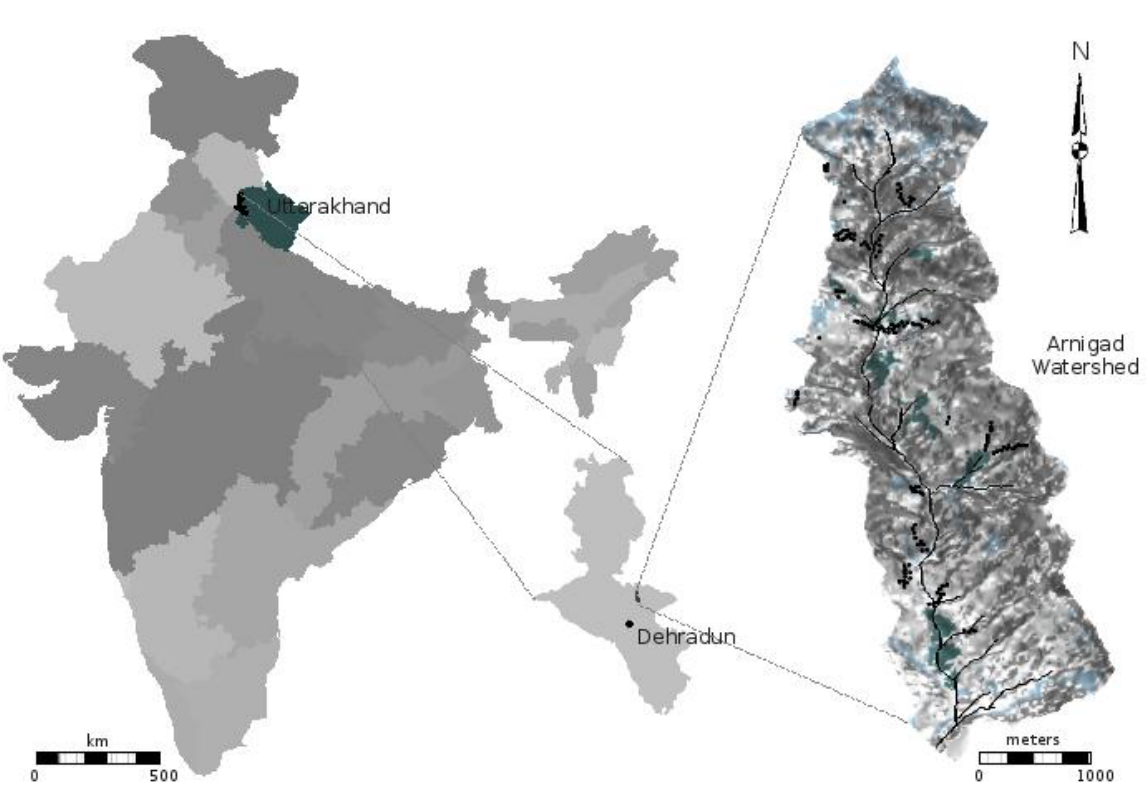
Figure 1. Location of the study watershed in Uttarakhand, India and a view of the watershed showing the field sampling